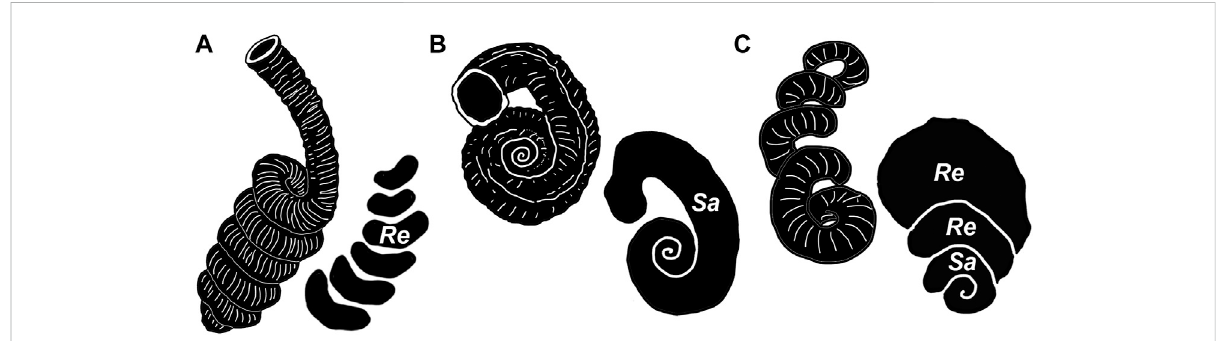
FIGURE 4 Idealized vermetid shell types responsible for the ichnogenera treated here. (A) Petaloconchus -like high trochospiral coiling responsible for Renichnus arcuatus (Mayoral, 1987). (B) Serpulorbis -like planispiral coiling responsible for Santichnus mayorali . (C) irregularly coiled vermetid shell that combines a tight spiral and loose whorls (based on ULL PA 458, see Panel 8A), responsible for compound forms of Renichnus – Santichnus . ( Re : Renichnus ; Sa : Santichnus ) Not to